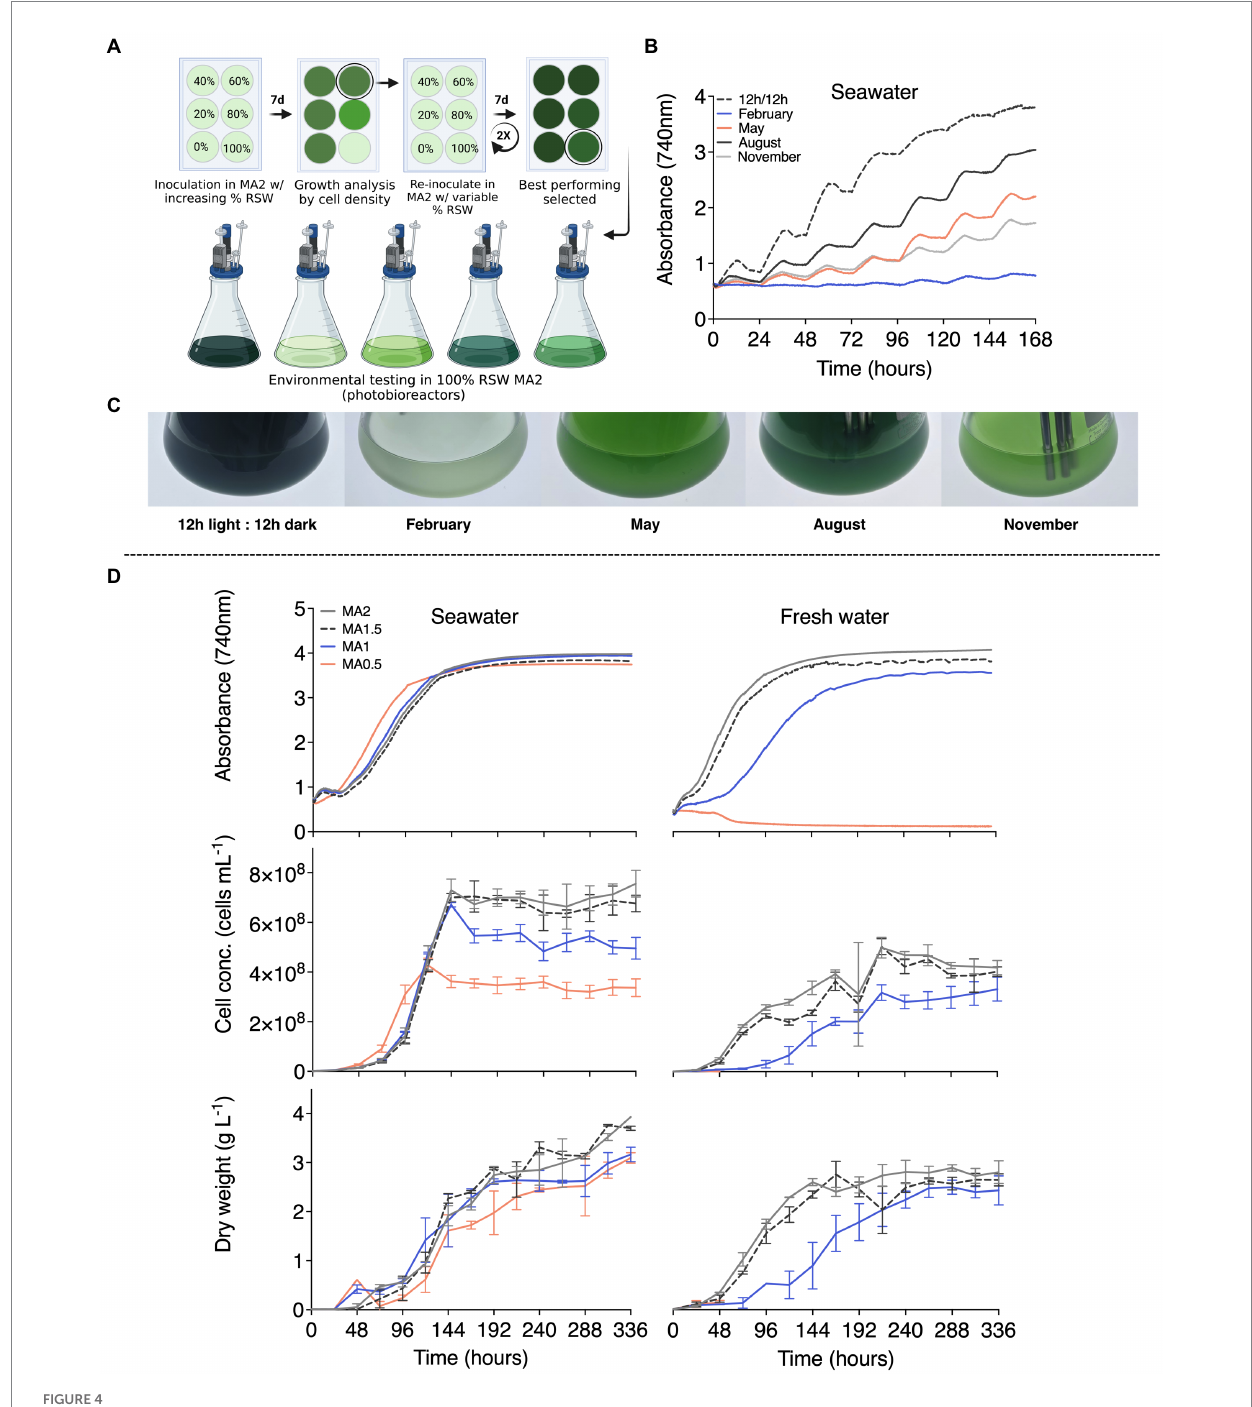
FIGURE 4 Adaptation of C. merolae 10D to the hypersalinity of Red Sea water. (A) Inoculum cultures were grown for 168 h in a range of autoclaved Red Sea water mixtures with fresh water and MA2 nutrient supplementation. At the stationary phase, the salt content condition that resulted in the highest cell density was used as inoculum for the same conditions in a new culture plate. This process was repeated for a total of 4 passes until reasonable growth was observed in 100% Red Sea water MA2 medium. This culture was used as inoculum for (B) photobioreactor modeled environmental testing of C. merolae 10D performance in temperature and light conditions for different seasons on the mid-Red Sea coast (as illustrated, upper left). Optical density (OD 740 nm ) was recorded continuously for the salt-water adapted C. merolae for a control culture (42 ° C with 12:12 h day:night illumination), modeled seasonal programs for February, May, August, and November were used to simulate winter, spring, summer, and autumn, respectively (upper right). (C) Culture performance was also observed photographically at the end of cultivation (pictured). (D) Saltwater adapted and its freshwater progenitor C. merolae 10D were subjected to continuous illumination and 42 ° C temperature conditions with culture media made using different ratios of MA2 nutrient solutions to determine the possibility of reducing nutrient inputs for its growth. Culture performance was assessed by continuous optical density monitoring in the photobioreactors, daily cell density, and biomass (dry weight) measurements over 336 h. Figure partially created with